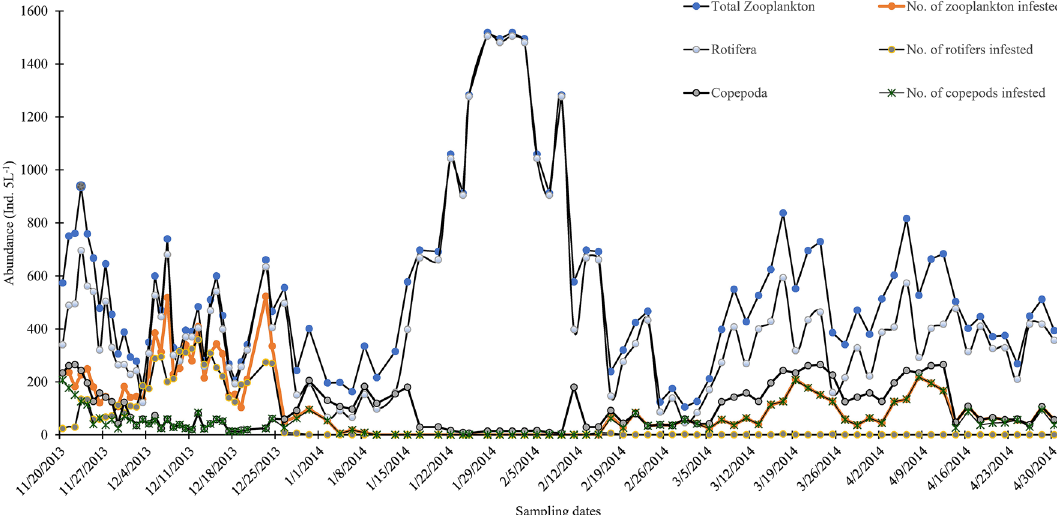
Figure 2. Total abundance and individual numbers colonized (individuals 5 L −1 ) by epibionts at each sampling date during November 2013 to April 2014, from the flood plain wetland of the river We recorded a total of three genera of epibiotic protista including ciliates ( Rhabdostyla Kent, 1880 and Epistylis Ehrenberg, 1830) and the mixotrophic flagellates ( Colacium vesiculosum Ehrenberg, 1853). The number of epibionts varied from species to species of the group of zooplankton as shown in (Figs. 3 and 4). Association of epibionts were observed highest in copepods ( Mesocyclops sp.) (Fig. 4) followed by nauplii and rotifers. Interestingly, Asplanchna was found free of epibiont infestation throughout the study period. Colonisation by epibionts was observed on Ceriodaphnia, Brachionus and Polyartha. But no ovigerous female Ceriodaphnia was observed throughout the study period. Infestation load was recorded on all stages of copepods including males, ovigerous and non-ovigerous females, copepodids, and nauplii. The species–specific frequency distribution of epibionts for zooplankton species was ≥ 5% population where one or more showed epibionts. In the present study zooplankton species loaded with epibionts were observed in some rotifer species such as Keratella, Hexarthra , Polyarthra , Filinia, and Brachionus adults ovigerous and non-ovigerous were also found with differential loads of epibionts (Figs. 1, 3). Copepod adults ovigerous and nonovigerous both, their develop- mental stages -nauplii and copepodid stages (Fig. 4) were heavily infested (up to 53 epibionts Ind −1 ). Infestation levels (no. of epibionts basibiont −1 ) on copepod nauplii, copepod adults, Keratella cochlearis , Polyarthra vulgaris, Filinia longiseta , Brachionus rubens and Hexarthra mira are given in Figs. 3 and 4. In consideration with per unit surface area the infestation load on evasive rotifer P. vulgaris was maximal, followed by H. mira and K. cochlearis whereas among copepods juvenile stages were more susceptible than adult copepods. Epibiont density per unit surface area of the basibionts ranged from 0.73 in B. rubens to 207.3 cells mm −2 in P. vulgaris. Relative susceptibility of per individual zooplankton to epibiont infestation was highest in case of males, copepodids, nauplii followed by non-ovigerous female adult cyclopoids. Ovigerous copepods were found less susceptible to epibionts (Fig. 4) than other copepod life stages. However, in terms of per unit body surface area copepod nauplii and copepodids were more loaded with epibionts than adult copepods. The prevalence of epibiont numbers on ovigerous females, copepodids and nauplii was correlated with tem- perature (range: 16.5–31.5 °C; mean ± SE: 22.6 ± 2.25). In general, 2 to 53 epibionts were recorded on each indi- vidual zooplankter during this study. A maximum of 53 individuals of epibionts were recorded on a copepodid body on 21st November 2013. Average numbers of epibionts recorded per individual rotifer as provided in Fig. 3, that for each individual copepod of different developmental stages is provided in Fig. 4. Significantly lower num- bers of epibionts were observed on all developmental copepod stages in February 2014 (Mann Whitney U test). The swimming movements in infested and uninfested adults and copepodids of Mesocyslops were monitored in 90 mm diameter petridishes with a bottom-grid composed of 1 × 1 cm cells. Swimming paths were traced and numbers of power strokes (leaping) were recorded and repeated for one minute, observations for at least five individuals of infested and uninfested adults and copepdid stages of Mesocyslops . No. of power strokes for copepodids were significantly higher than those of adult Mesocyslops and displacement rates were significantly lower in infested copepodids and adults than the corresponding uninfested individuals. Effects of epibiosis on predation by basibiont (copepod). Seven different types of food species (Table 1) differing in swimming pattern, evasiveness, body size, and taxonomic groups and co-occurring in the same wetland, from where epibionts were recorded. These were used for feeding trials with infested and uninfested adult and copepodid stages of Mesocyclops . The length, width and dry weight of prey species, used in the feeding trials are provided in Table 1. All the infested organisms used in feeding trials were colonised by heterotrophic ciliates only. All the prey species were fed to infested and uninfested adults and copepodid stages to assess the impacts of epibiosis on basibiont predation (Fig. 5). The prey preference in copepods differed sig-